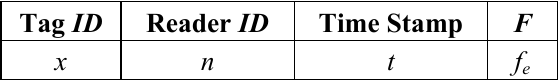
Table 4. Structure of inter-cluster node data packet.